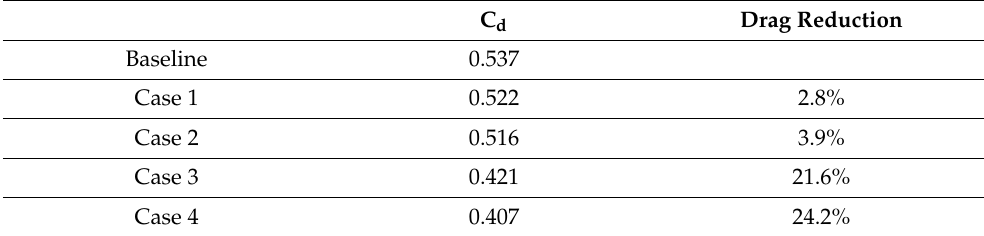
Figure 6. The predicted Cd variation with the number of iterations. Table 1. Predicted drag coefficients (C d ) and corresponding drag